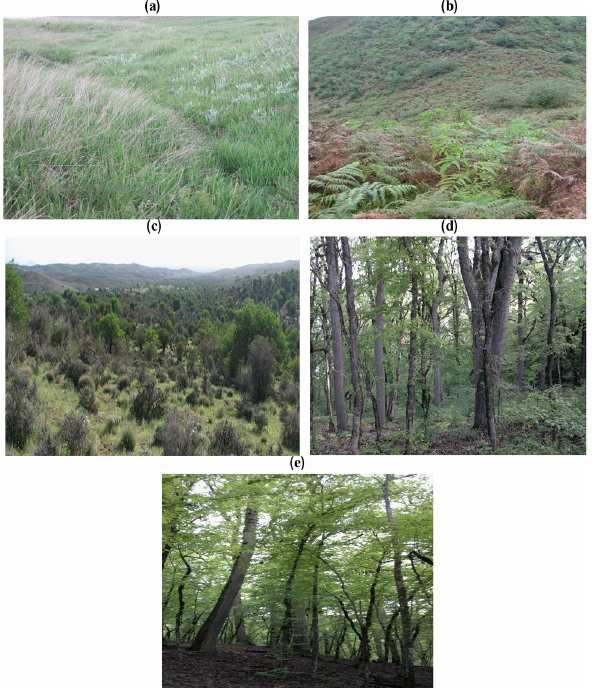
Figure 6. Photo guide of the main fuel types of the study areas: (a) grasslands (GR3, GR4, GR5, GR6, GR7 and FM3 fuel mod- els), (b) grass–shrublands (GS1, GS2, GS3 and GS4 fuel models), (c) shrublands (SH1, SH2, FM5 and FM6 fuel models), (d) natu- ral mixed forest (TU1, TU2, TU3, TU5, FM8, FM9 and FM10 fuel models) and (e) natural pure forest (TL2, TL6, TL8, TL9, FM9 and FM10 fuel